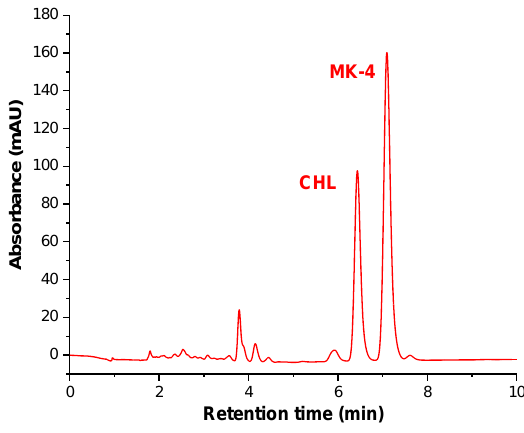
Figure 3. Chromatogram plot of dietary supplement DS-CHL@MK4.